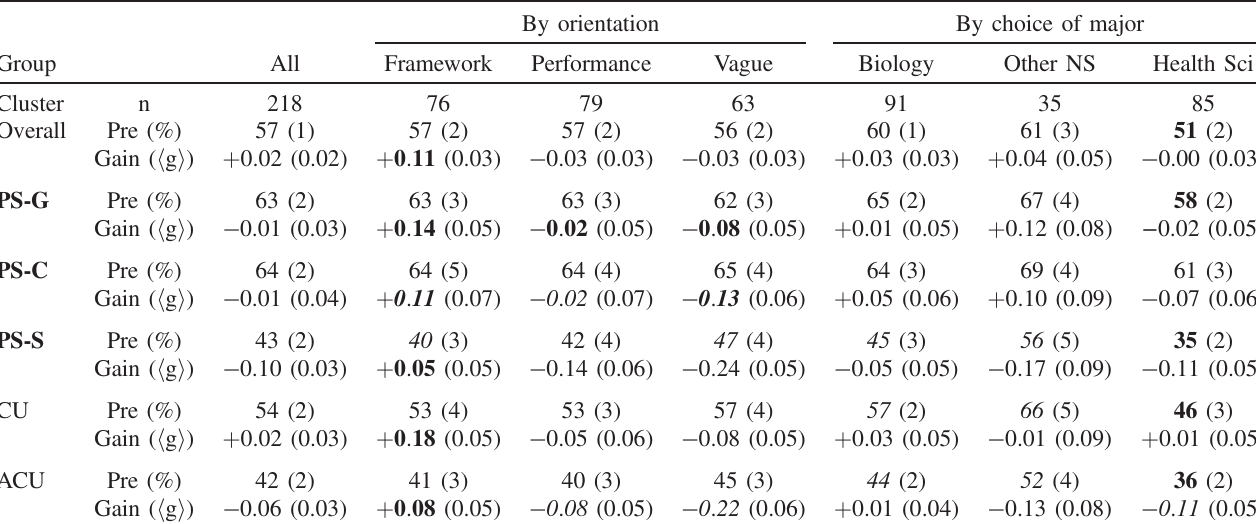
TABLE II. Average pretest scores and gains for students by major on CLASS item clusters, in terms of percentage of answers that are expertlike. Standard errors are presented in the brackets [e.g., “ ð 3 Þ ” ¼ þ = − 3% ]. Bold numbers indicate statistical significance within a row, either by orientation or by choice of major; italicized numbers similarly indicate borderline statistical significance. Please see text discussion on statistical differences for further